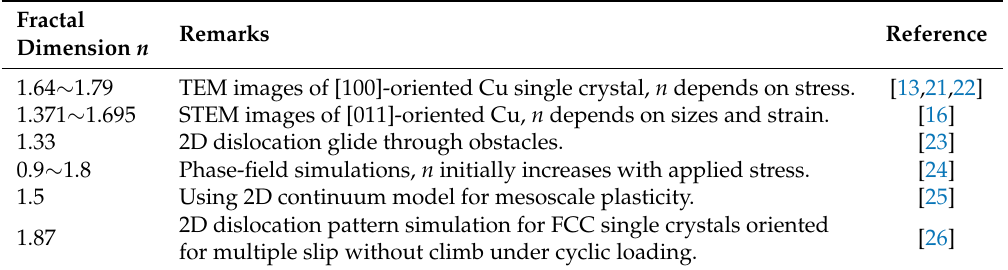
Table 1. Fractal dimension of dislocation cellular structures estimated through experiments or theoretical